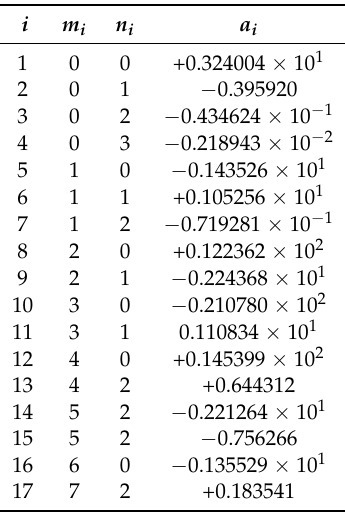
Table 2. Coefficients for Equation